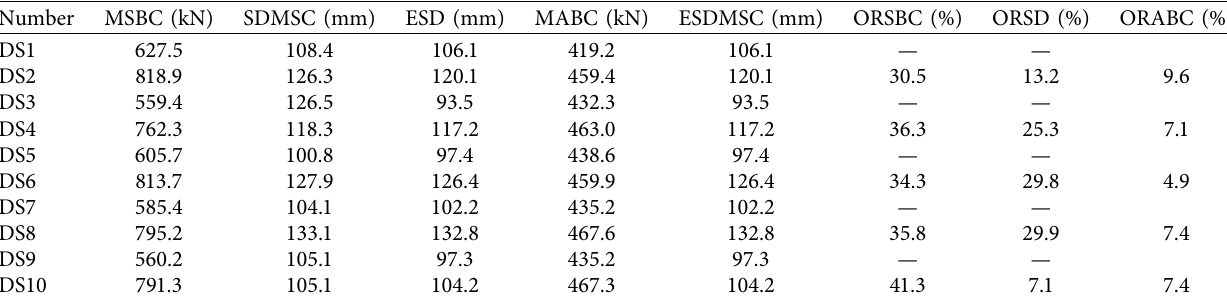
Table 2: Statistics of double-shear test